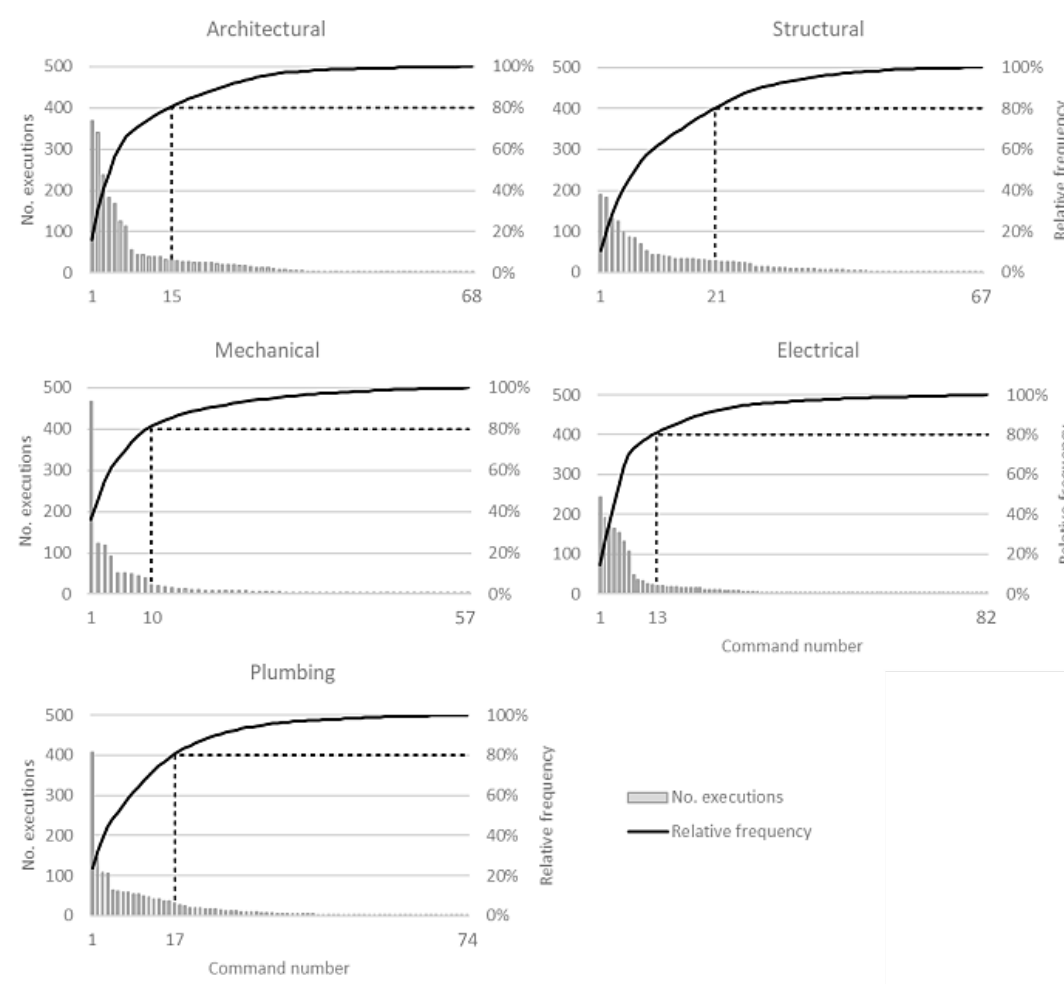
Figure 4. Pareto charts of contributory commands for each specialist.